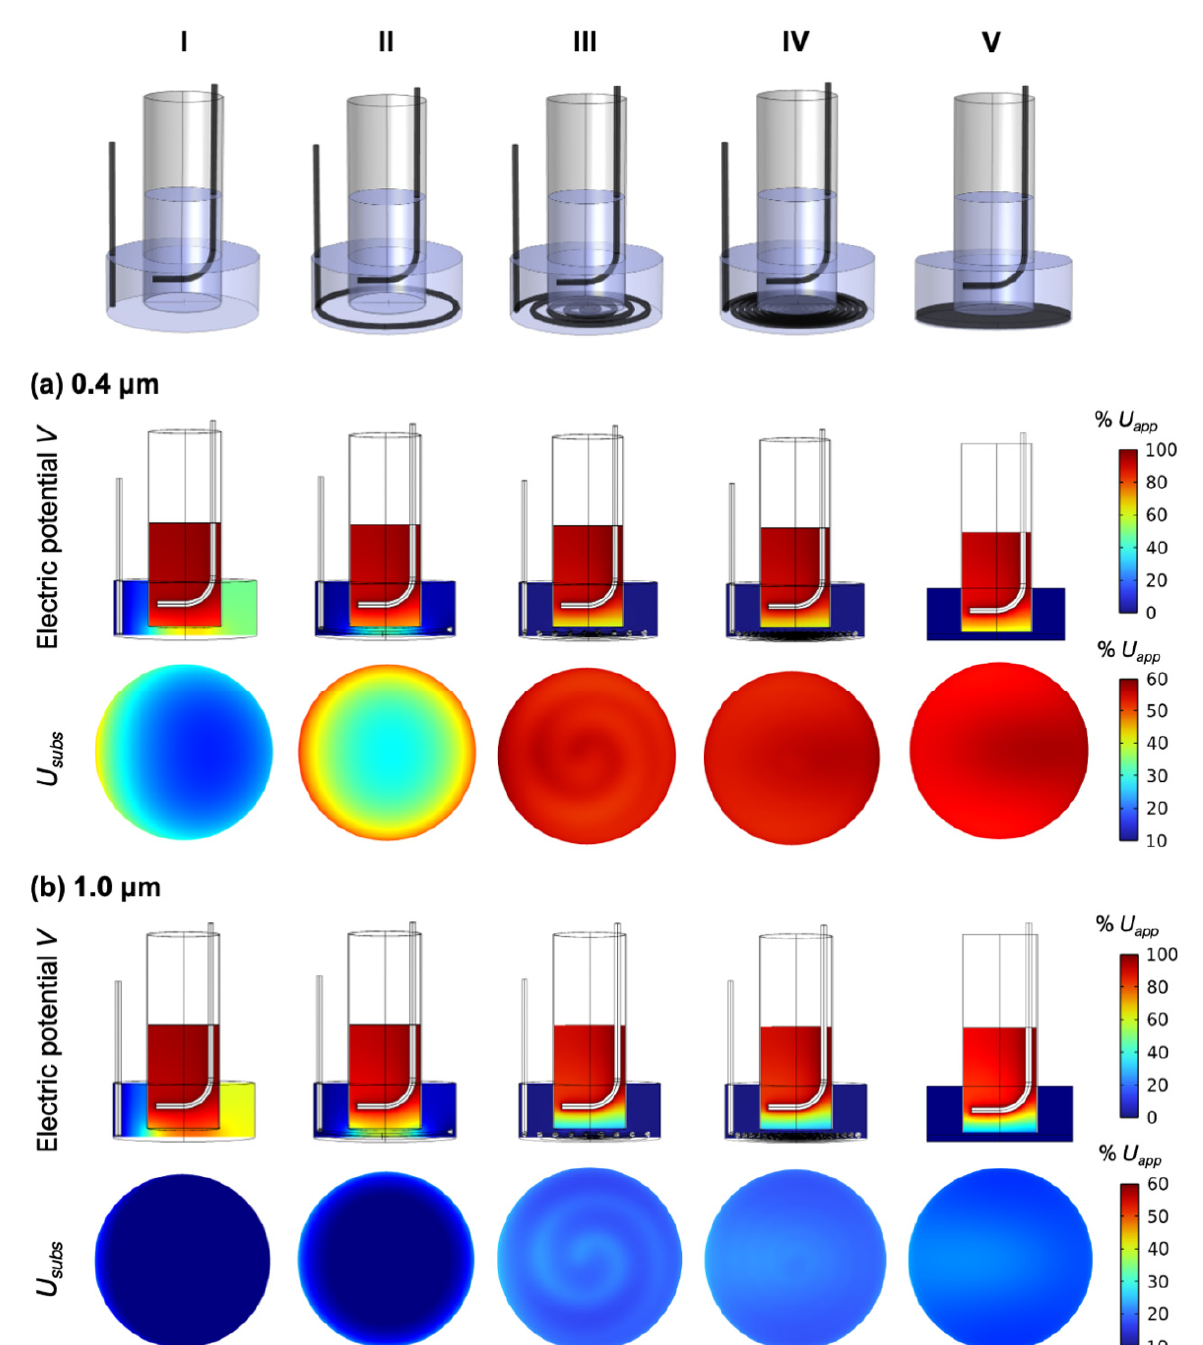
Figure 3. Influence of the electrode configuration. The images in the top row show the tested electrode configurations ( I – V ). ( a ) Electric potential distribution in the insert system and the voltage drop over the substrate U subs for the different electrode configurations. Calculations are for substrates with 0.4 µ m pores. The electric potential and U subs are expressed as the fraction the voltage applied to the electrodes, U app . ( b ) Same calculations as in ( a ) but for substrates with 1.0 µ m